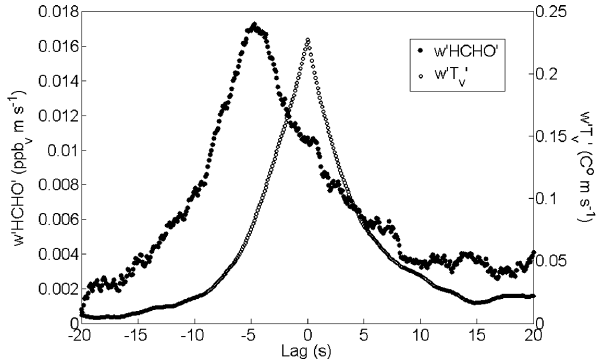
Fig. 1. Lag time vs. correlation plot for vertical wind speed ( w ) with both HCHO and virtual temperature ( T v ). Data shown is an average of all half-hour flux intervals from 06:00 to 18:00 on 30